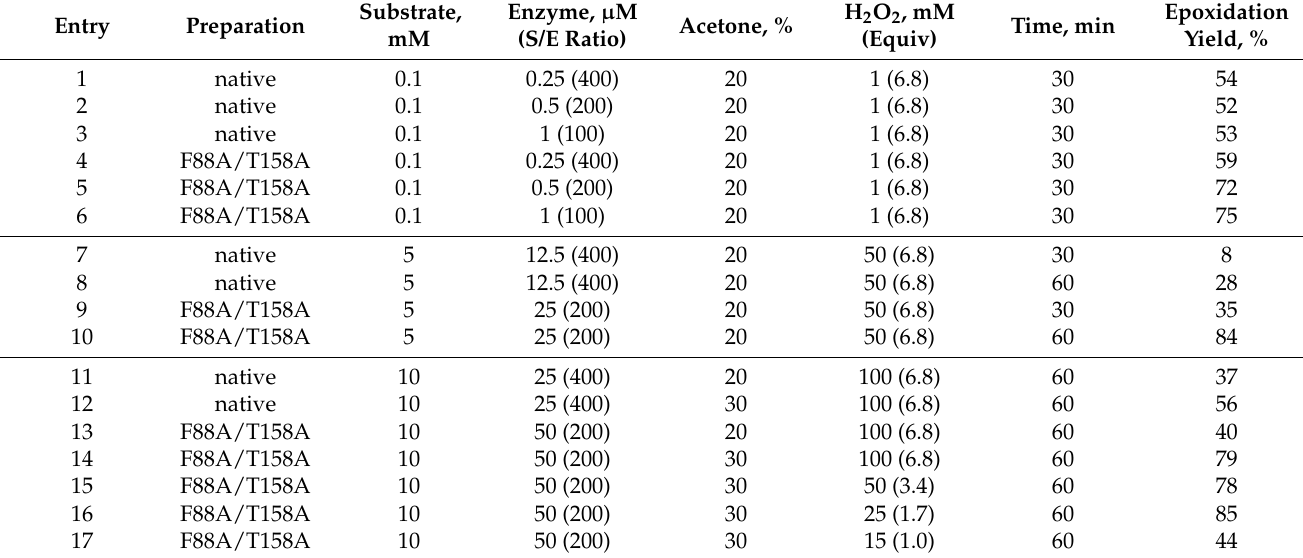
Table 4. Optimizing epoxidation yield (as percentage of the number of total double bonds present) in treatment of sunflower oil hydrolyzate with the selected r Cvi UPO variant (F88A/T158A) compared with native enzyme, by varying reaction parameters—such as substrate loading (mM), enzyme